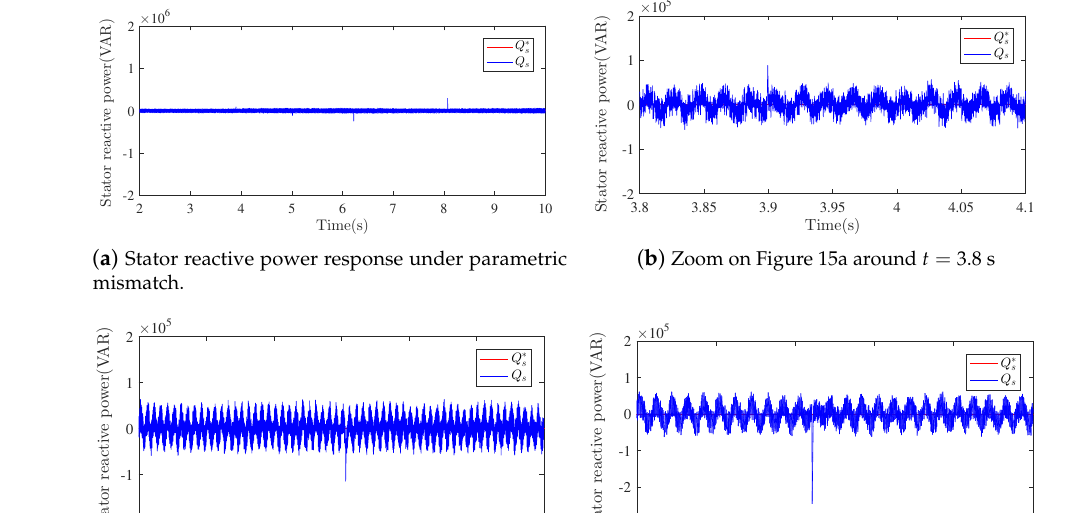
( c ) Zoom on Figure 15a around t = 4.4 s ( d ) Zoom on Figure15a around t = 6 s